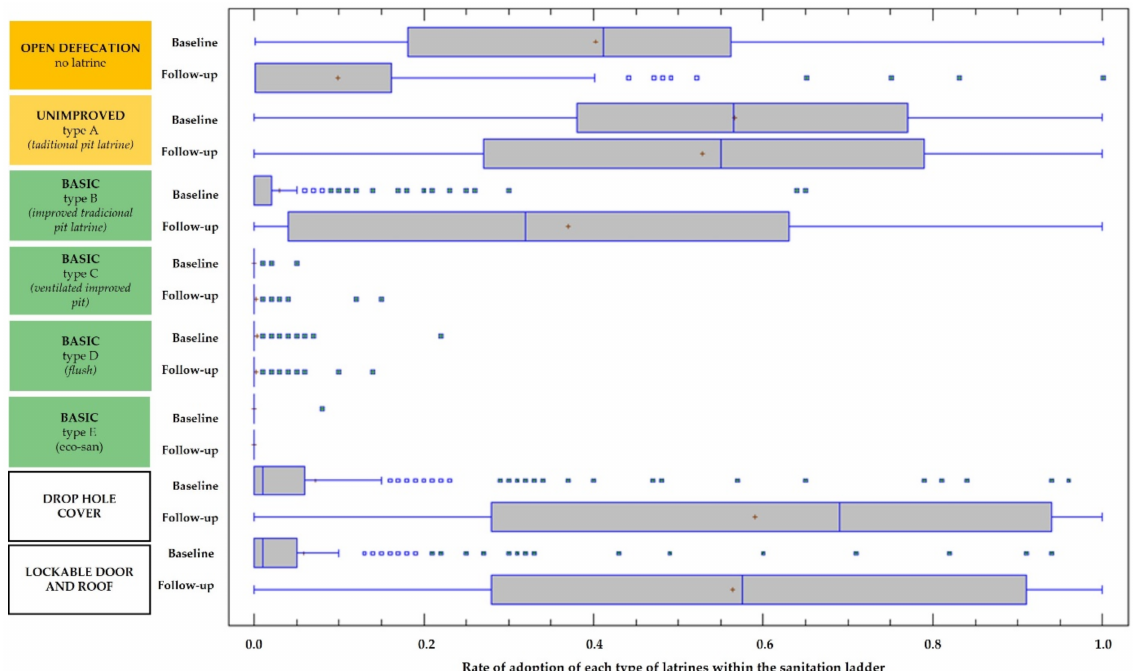
Figure 4. Box-and-whisker plot of the rate of adoption of each type of latrines within the sanitation ladder. Chamwino District before (baseline) and after (follow-up) the Programme. Data of the 241 subvillages interviewed.